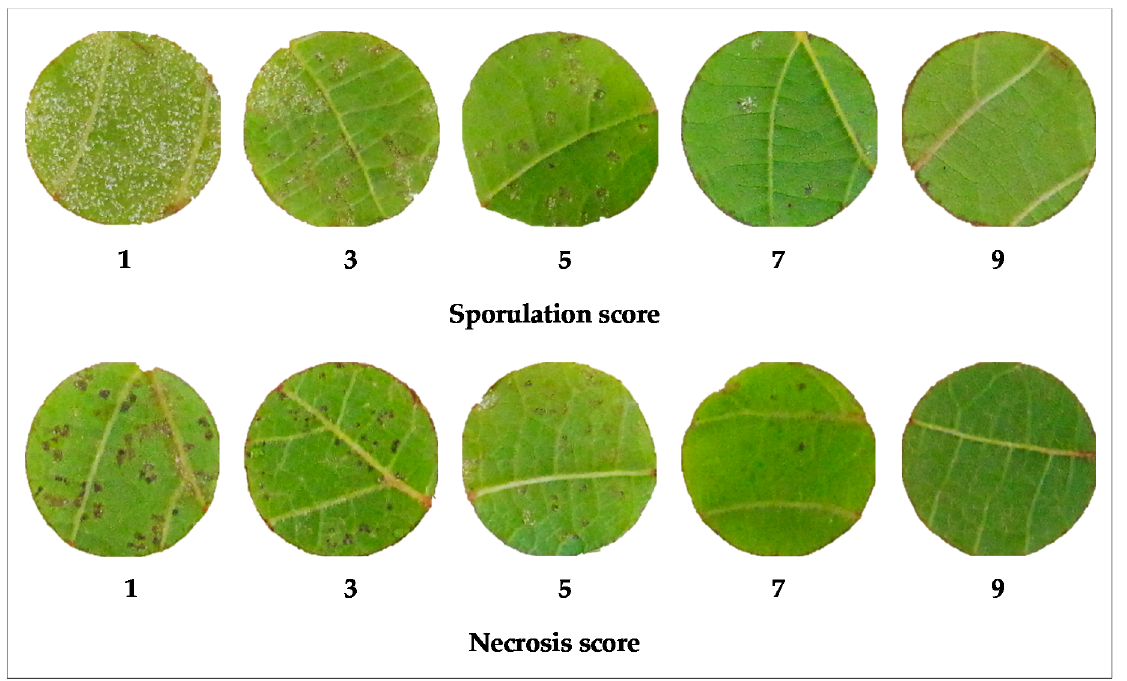
Figure 1. Dual-scale classification of symptoms. Sporulation and necrosis were evaluated separately by visual inspection of each leaf disc at 9 days post-inoculation with P. viticola .